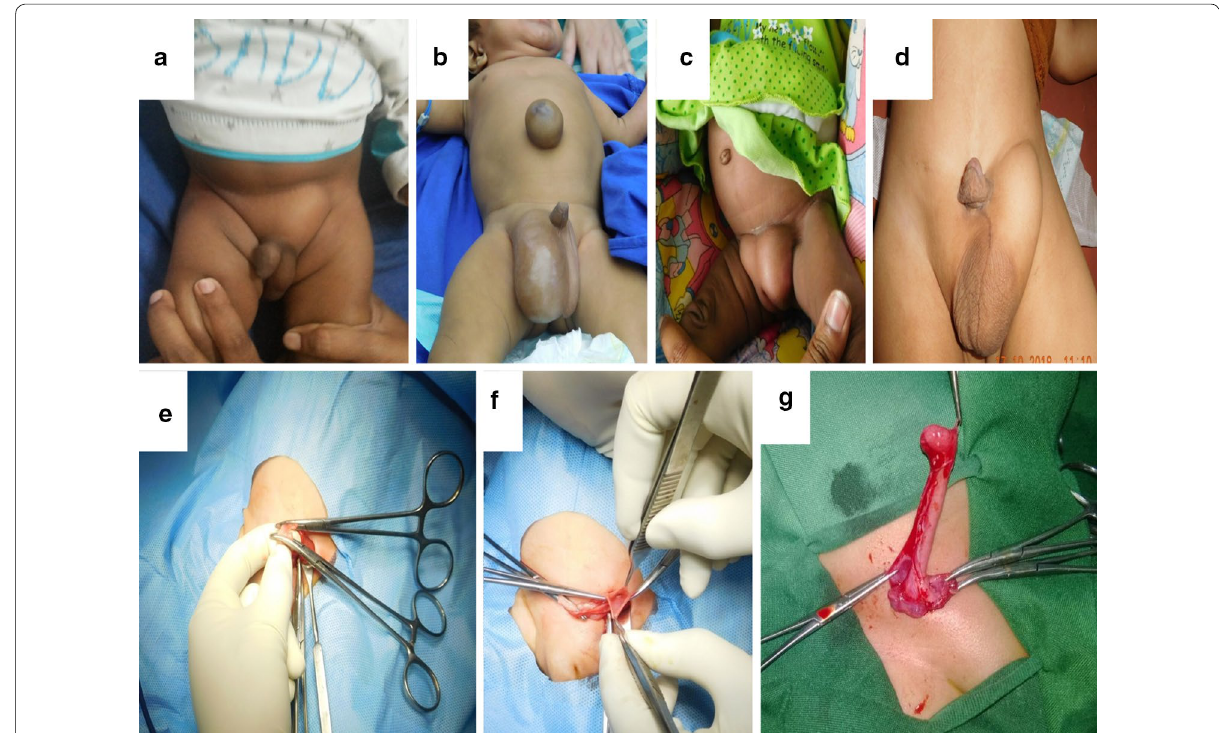
Fig. 1 a Clinical appearance of left-sided inguinal hernia. b EHBA associated with right inguinal hernia and umbilical hernia. c Female neonate with bilateral inguinal hernia. d Post op duplicated bladder exstrophy with recurrent metachronous inguinal hernia. e Intra-op picture-isolated hernia sac. f Proximal herniotomy sac without any contents. g Henial sac containing appendix. (EHBA—extrahepatic biliary